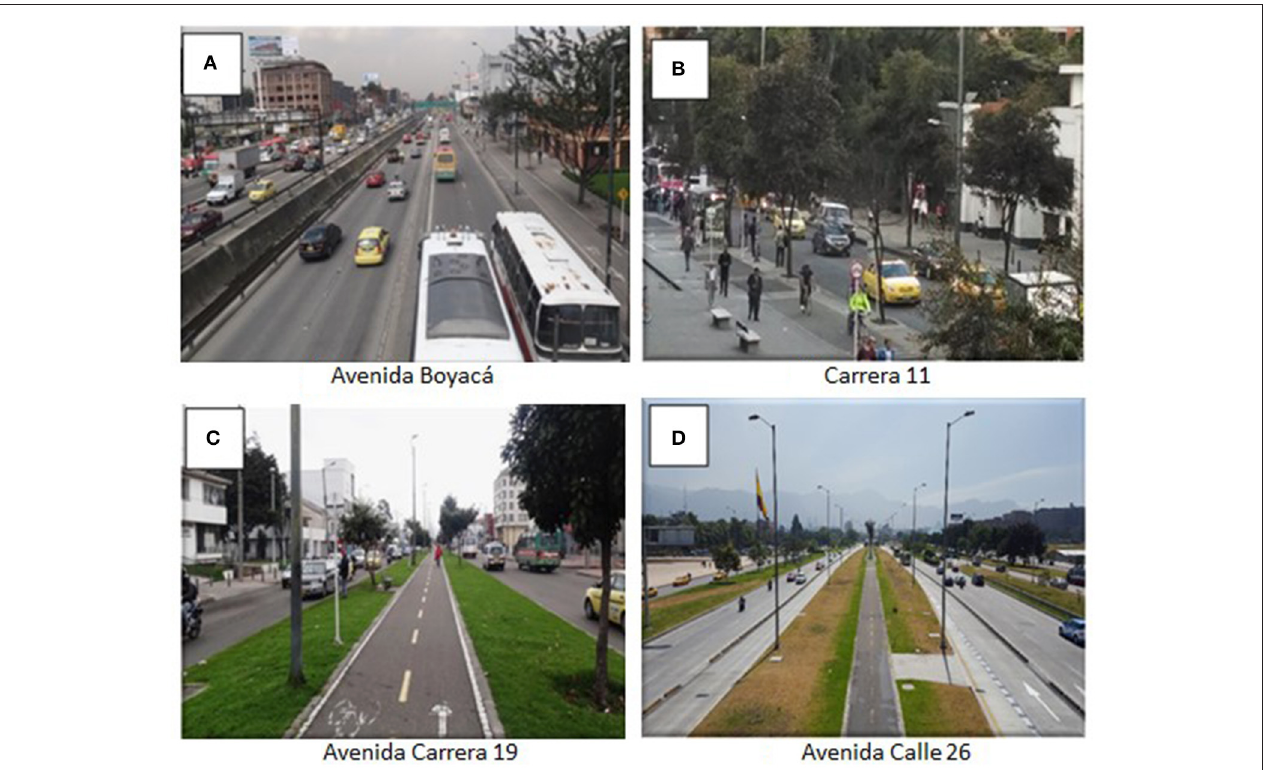
FIGURE 1 | Configuration of the streets and bike-paths selected for this study. (A) Open street with lateral bike-path; (B) closed street with lateral bike-path; (C) closed street with central bike-path; (D) open street with central bike-path.